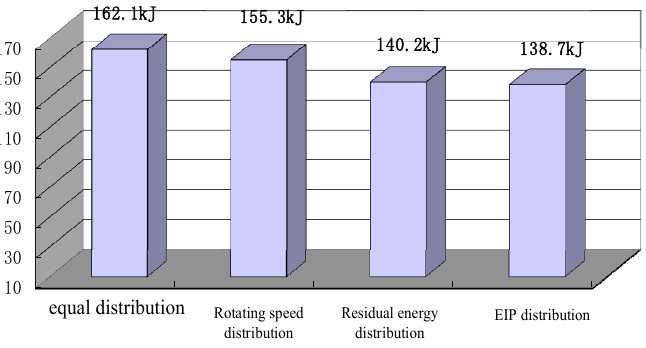
Figure 23. Comparison of total discharge loss.